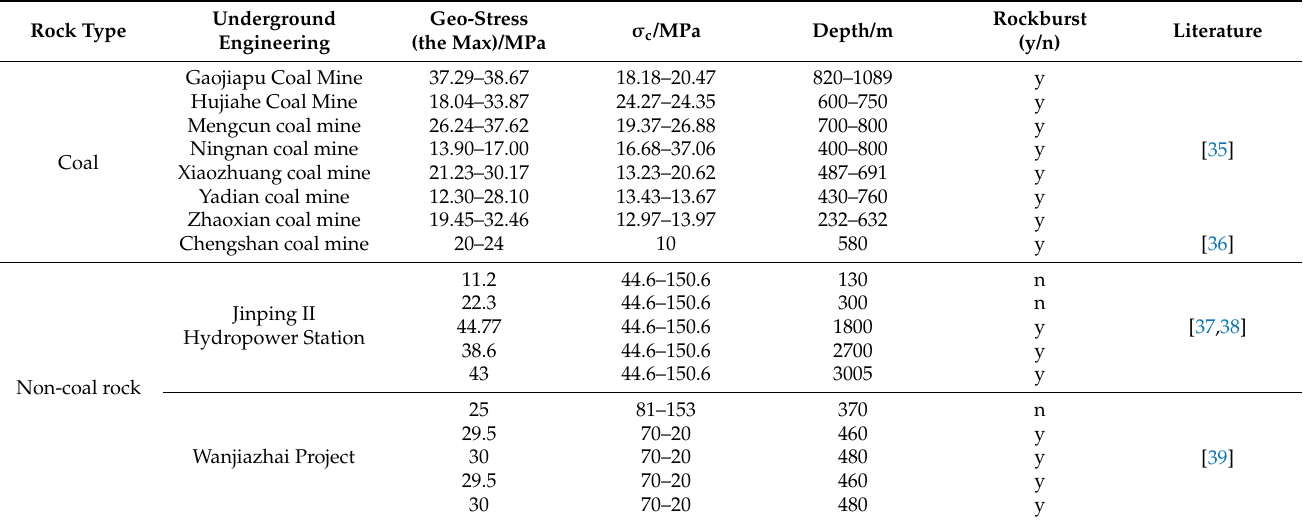
Table 5. Uniaxial compressive strength and geo-stress statistics of bursting coal and non-coal rocks. Rock